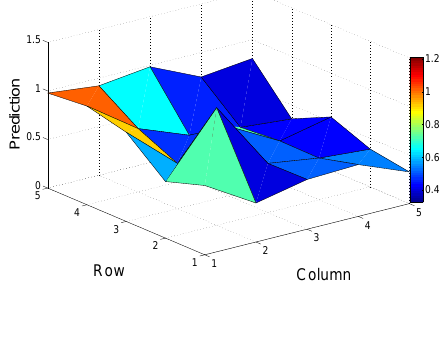
Fig. 15. The T distribution of optimal path of the experi- ment 2. e